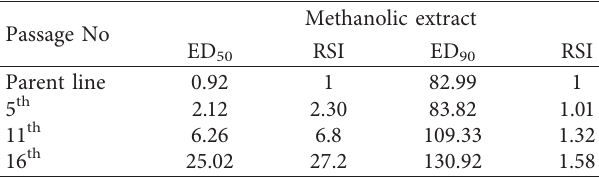
Table 6: Summary of the ED50, ED90 (mg/ml.day), and resistance index values of methanolic extract measured in the 4-day test during the drug selection pressure